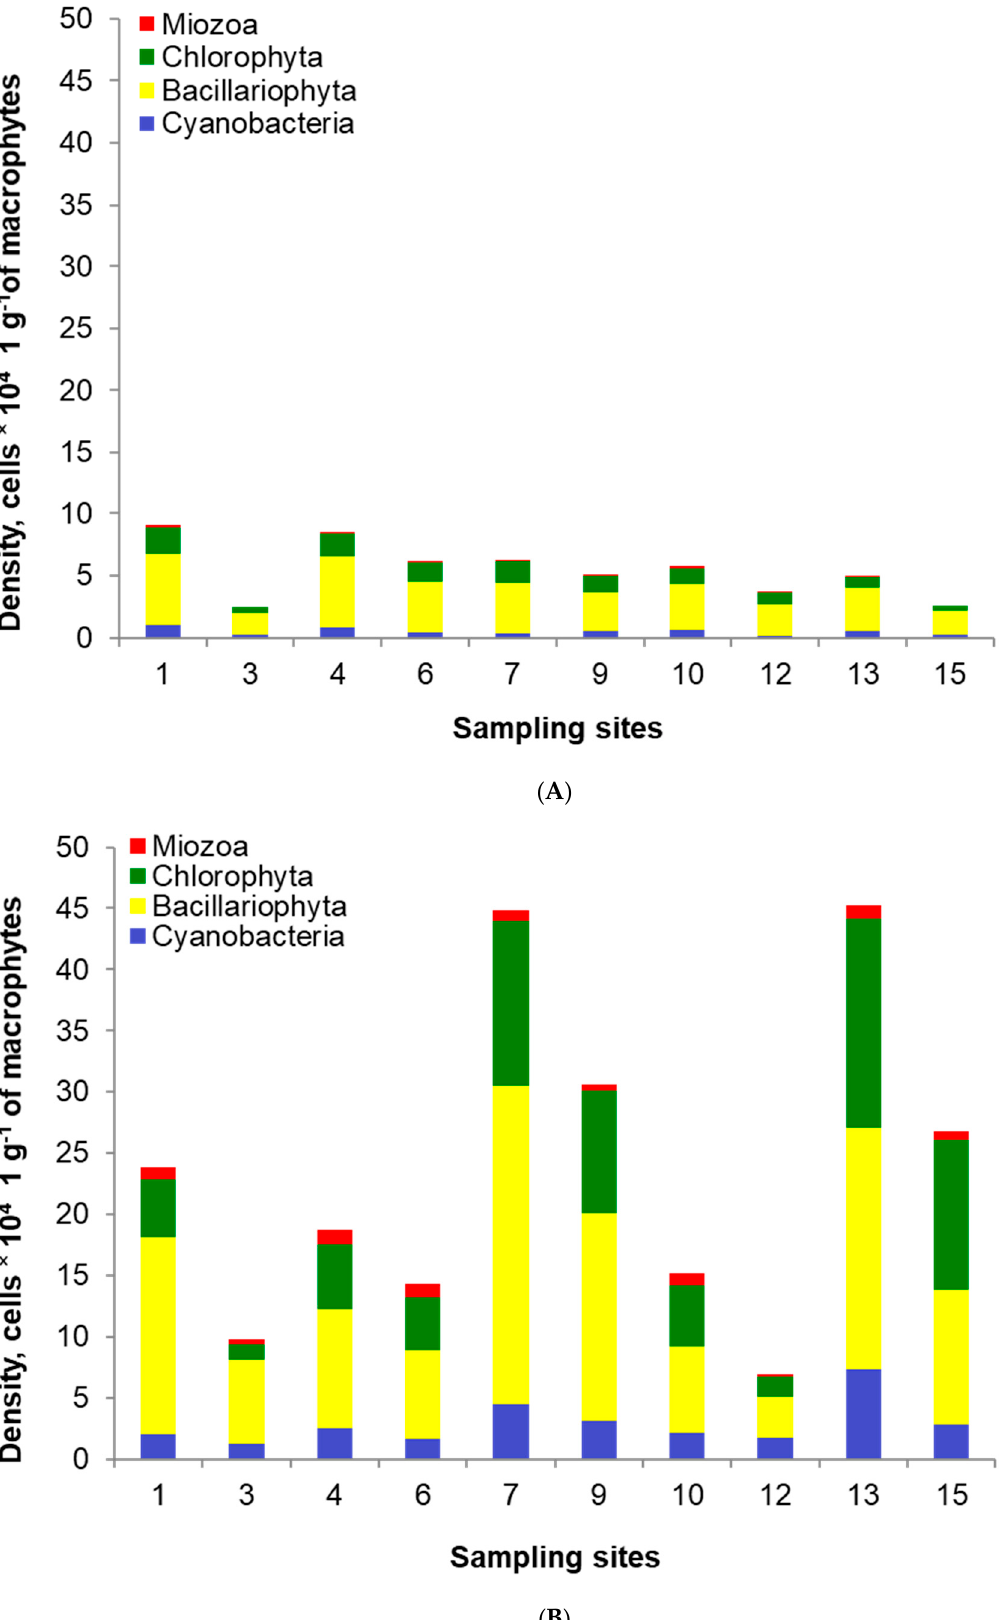
Figure 7. Epiphyte density and structure in the post-flood period ( A ) and the pre-flood period ( B ) in the main channel of Lake Nasser; the sampling sites concern only the sites in sectors 1 (1, 3), 2 (4, 6), 3 (7, 9), 4 (10, 12) and 5 (13, 15) on the eastern and western banks, respectively, with detailed information in Table